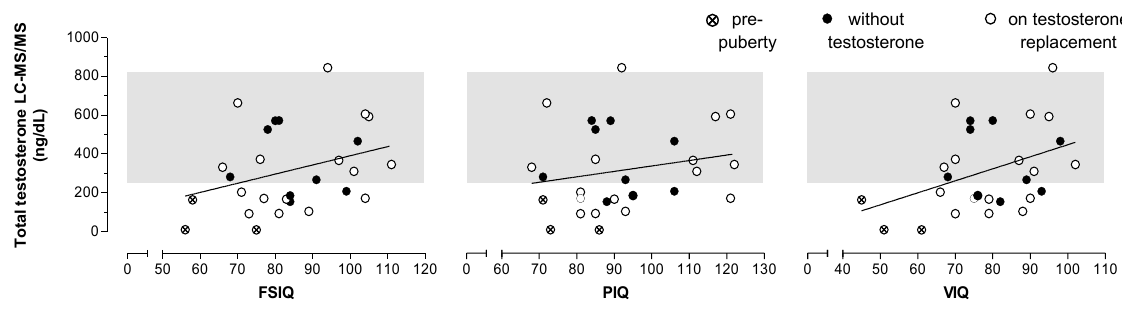
Figure 1. Graphic representation of simple linear regression and correlation between total testosterone and intellectual performance (28 participants). Full- Scale (FSIQ), Verbal (VIQ), and Performance (PIQ) Intelligence Quotient in Klinefelter syndrome cohort. Gray shaded area represents the reference range for total testosterone measured by liquid chromatography tandem mass spectrometry (241–827 ng/dL). Pearson’s correlation r=0.4016, p=0.0341 for VIQ.